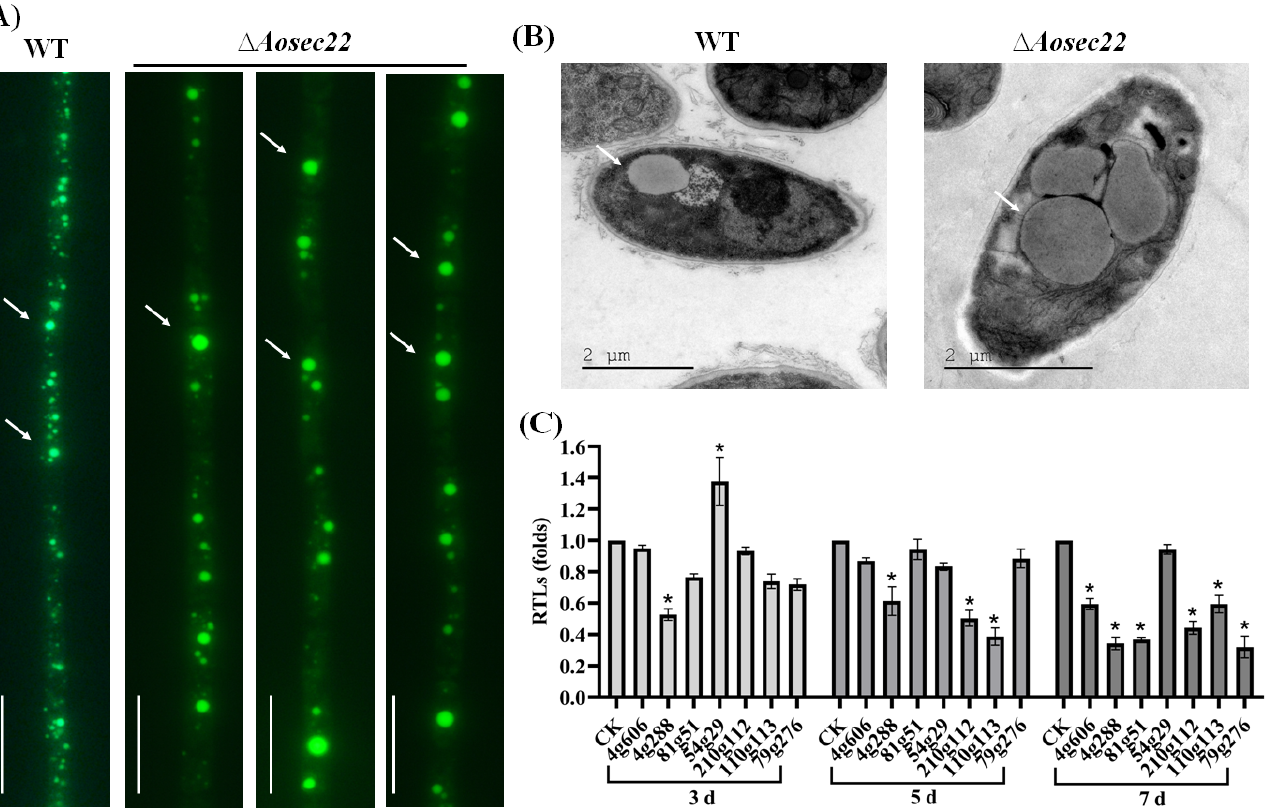
Figure 4. Impact of Aosec22 disruption on morphology of lipid droplets (LDs) and transcription of genes involved in fatty acid oxidation. ( A , B ) Microscopic (scale: 10 µm) and SEM images of LDs in hyphal cells. LDs in ( A ) were stained with 10 µg/mL BODIPY dye. Arrows: LDs. Bar: 10 µm. ( C ) Relative transcript levels (RTLs) of genes related to fatty acid oxidation between ∆ Aosec22 mutant and WT strains on days 3, 5, and 7. CK (standardized to 1) was used as a standard. An asterisk indicates a significant difference between ∆ Aosec22 mutant and WT strains (Tukey’s HSD, p < 0.05).